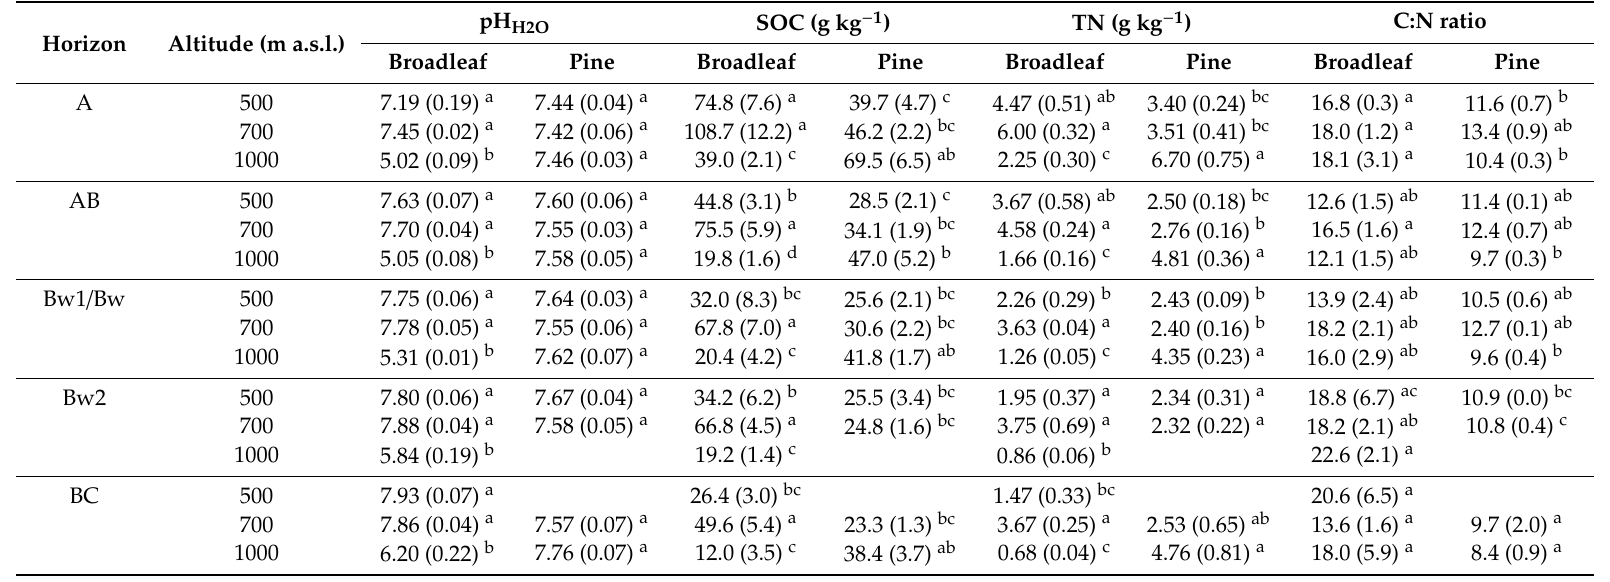
Table 1. Values of pH (in water), soil organic carbon (SOC) content, total nitrogen (TN) content and C:N ratio of the soils under the broadleaf and pine forests at